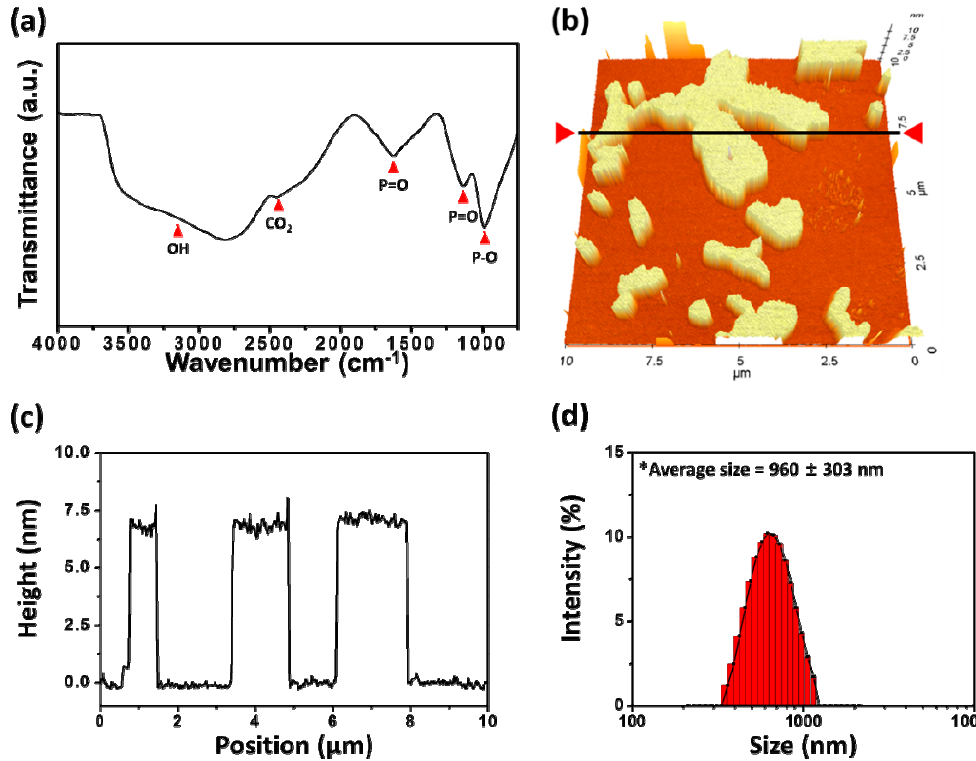
Figure 1. Characterizations of layered BP. ( a ) FT-IR spectrum of layered BP; ( b ) AFM image and ( c ) the height profile of layered BP along the black line marked in ( b ); ( d ) Hydrodynamic size distribution histogram of layered BP.